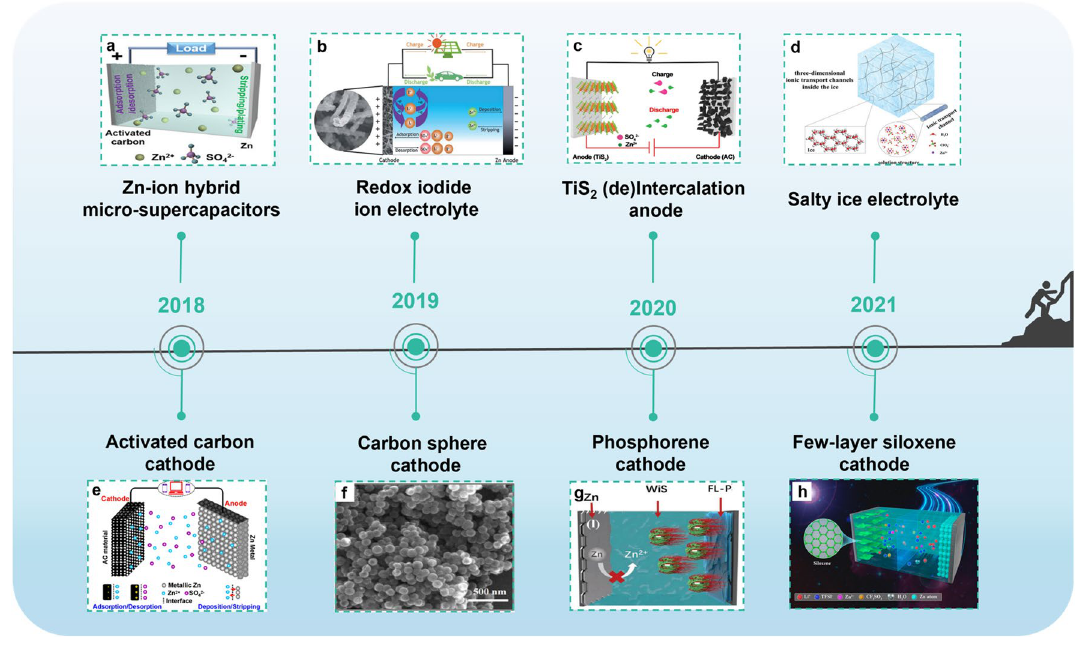
Fig. 1 Breakthroughs of ZIHCs in recent years. a A new-type Zn-ion hybrid micro-supercapacitor. Reproduced with permission [15]. Copy- right 2019, Wiley-VCH. b A redox iodide ion electrolyte and B, N dual-doped carbon electrode for ZIHCs. Reproduced with permission